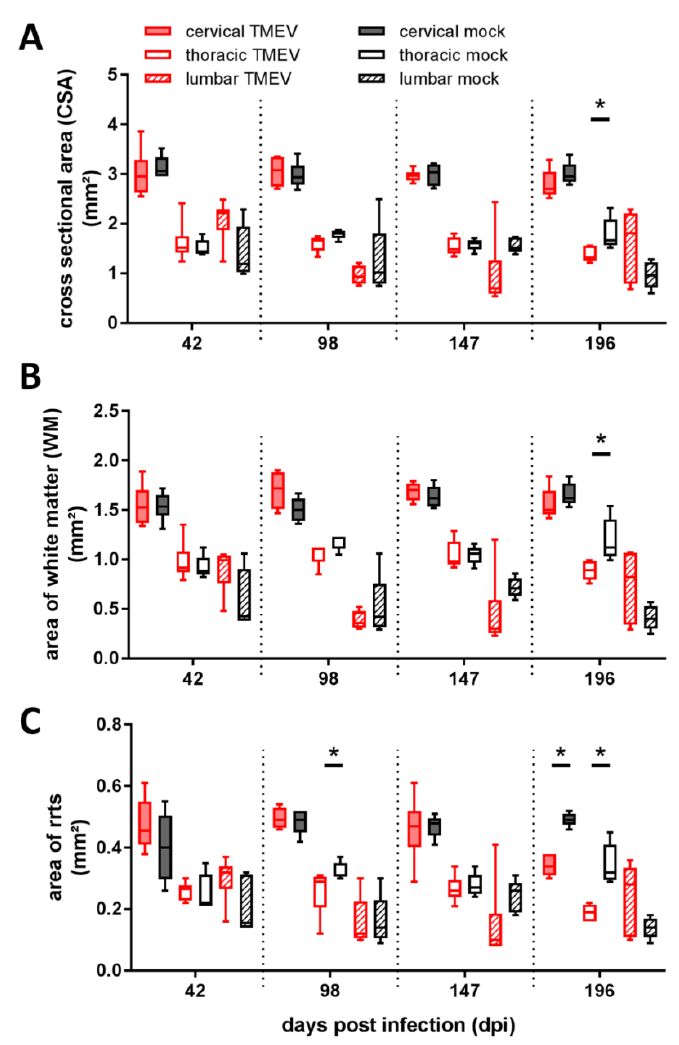
Figure 2. Assessment of spinal cord areas revealed a significant reduction of cross-sectional area at 196 dpi within the thoracic segment ( A ), accompanied by a reduction of thoracic white matter area at 196 dpi ( B ) and a reduction of the area of rostral reticulospinal tract (rrts) within the thoracic segment at 98 dpi and within the cervical and thoracic segment at 196 dpi ( C ). Graphs display box and whisker plots. Significant differences between groups detected by Mann–Whitney U -test were indicated by asterisks (* p ≤ 0.05), GM = gray matter, WM = white matter.